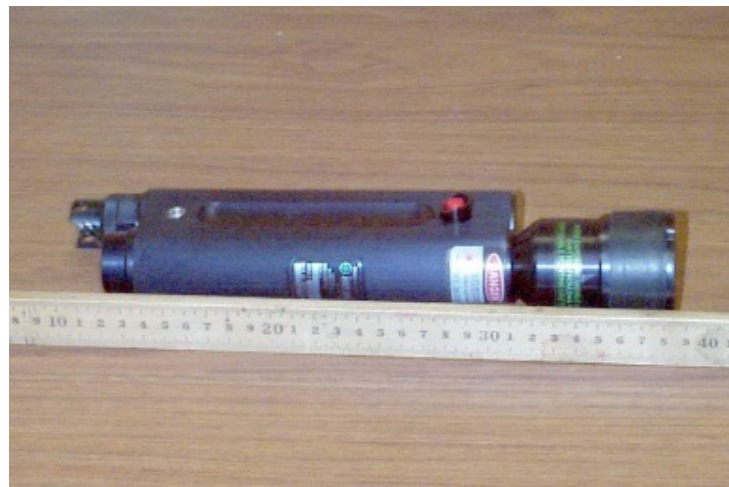
FIGURE 1 . Photo of battery-operated laser.